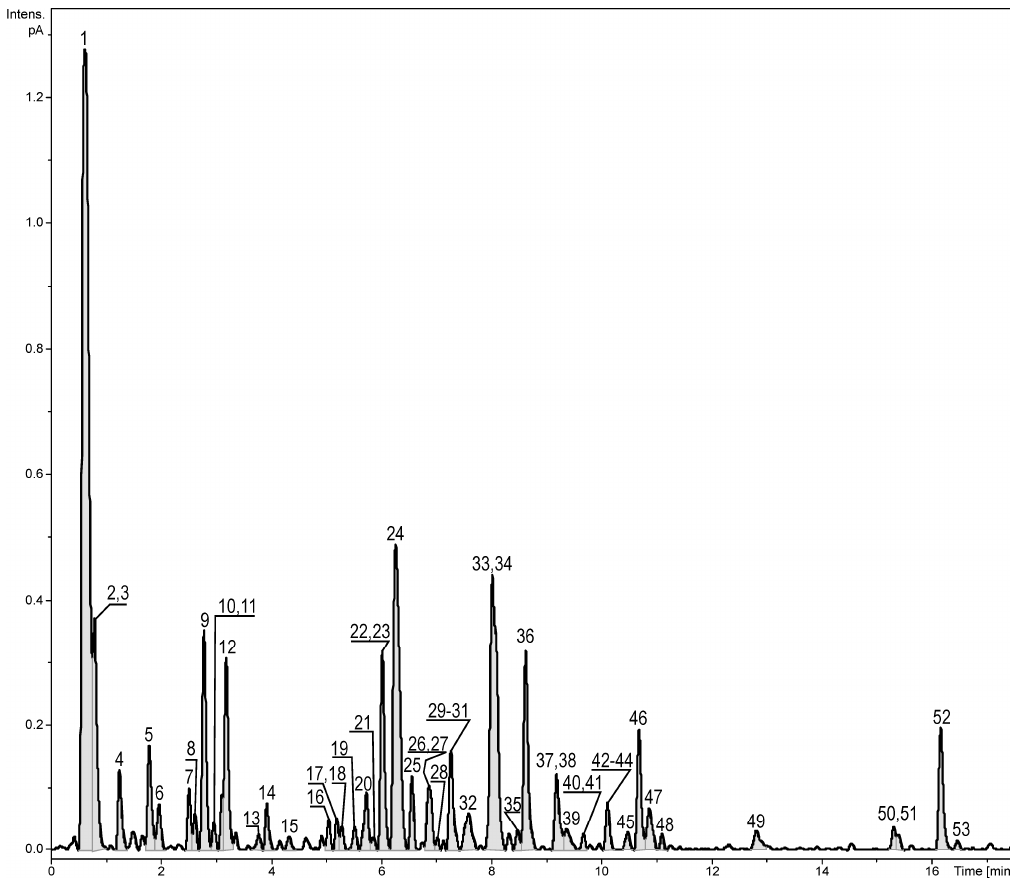
Figure 1. UHPLC-CAD profile of the Z. elegans methanolic extract.